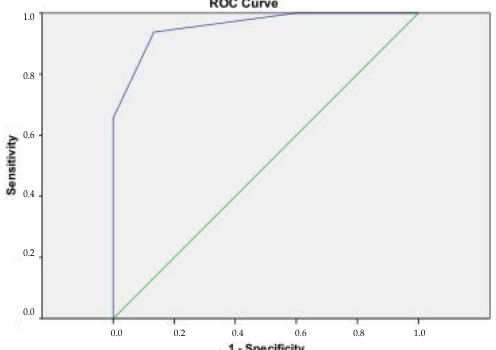
Figure 5. ROC curve for assessing the specificity and sensitivity of Euroimmun aero (as a panel positive/negative) vs. ImmunoCAP Phadiatop.